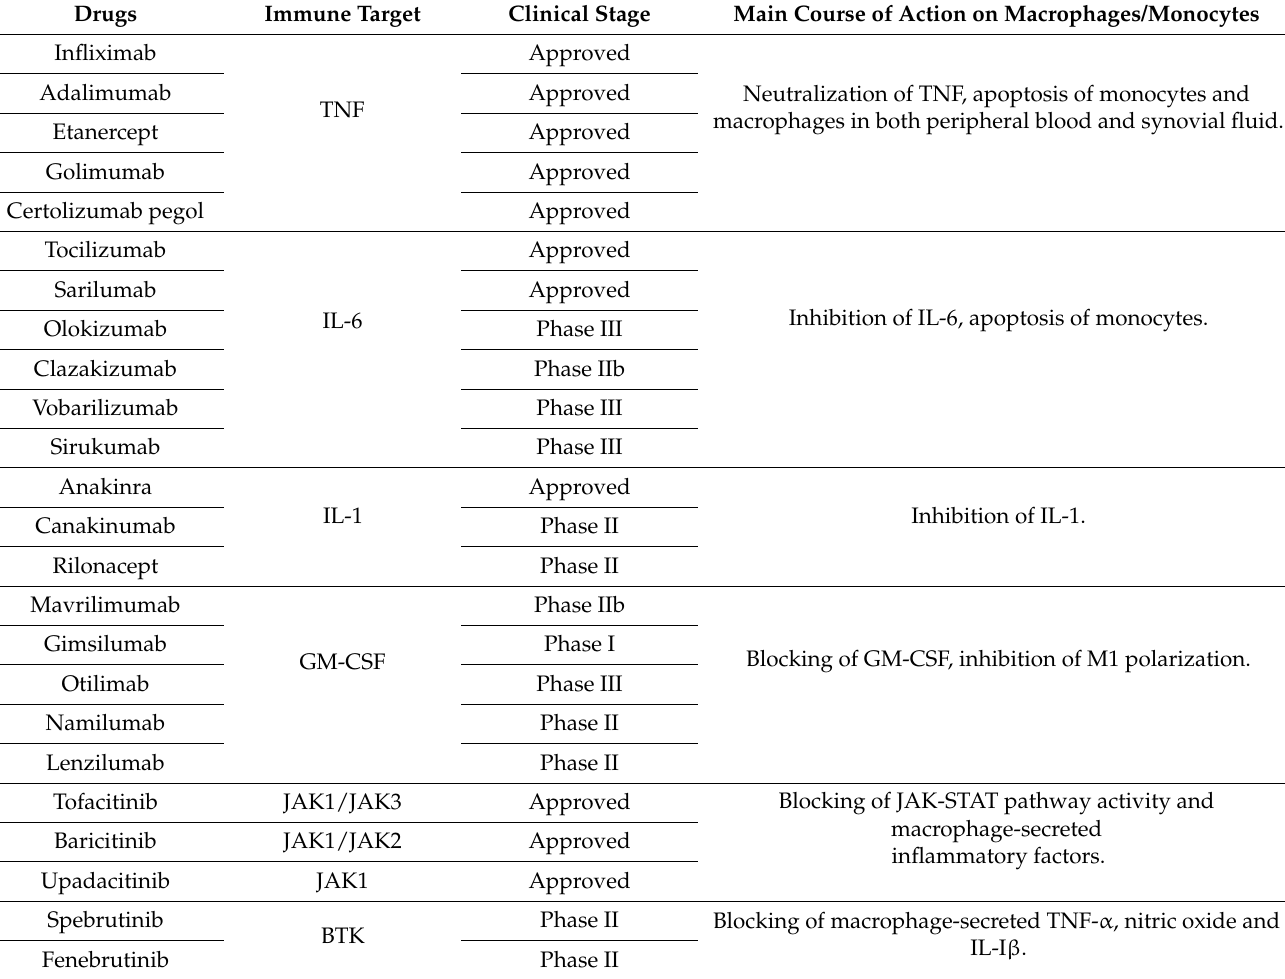
Table 1. Therapeutic drugs modulating monocytes/macrophages in